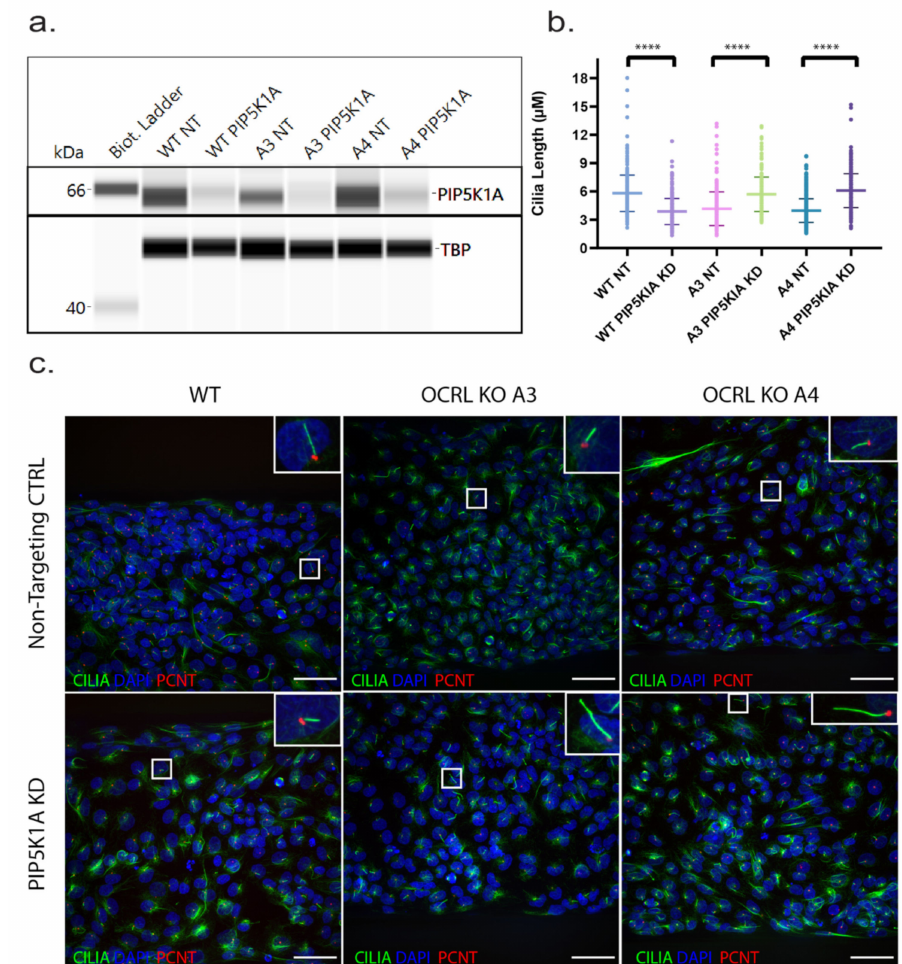
Figure 5. Cilia length defect in OCRL-KO cells was rescued by PIP5K1A KD: ( a ) Capillary-based Western blotting (WES) confirming a reduction in protein expression levels of the PIP5K1A gene in WT, OCRL KO A3 and A4. The first lane depicts the biotinylated ladder at 66 kDa. The bands detected by the PIP5K1A antibody with samples of non-targeting siRNA CTRL show a distinct band at ~65 kDa. TBP (TATA-Box Binding Protein) was used as a loading marker and detected at ~52 kDa. Images were derived from the Simple Western Compass software and used to analyse data generated by WES. ( b ) An aligned dot plot with the length of cilia measured in each condition with ImageJ software segment tool. Student Welch’s t -test, N = 3 (>50 cells per N ), ****, p < 0.0001, error bar represents ± SD. ( c ) Immunofluorescence images showing primary cilia stained with acetylated tubulin (green), pericentrin (red) and nucleus (blue) in WT, OCRL KO (A3 and A4) in PIP5K1A KD samples compared with their respective NT CTRL samples. Scale bar: 100